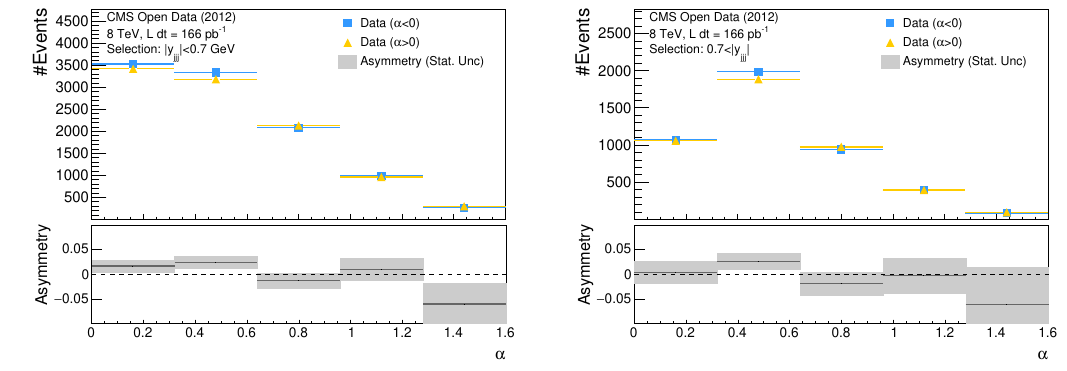
Figure 6 . Distribution of reconstructed events with (cid:11) < 0 and (cid:11) > 0 for events with j y jjj j < 0 : 7 (left) and 0 : 7 < j y jjj j (right). The ratio in each plots shows the asymmetry value including statistical